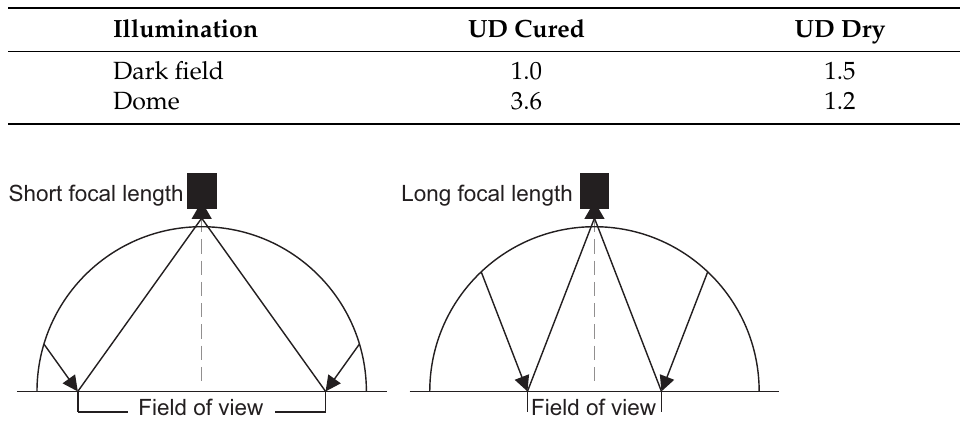
Table 4. Standard deviations (°) of measurements within the “full” ROI (see Figure 9) for dark field and dome illumination (12 mm lens).